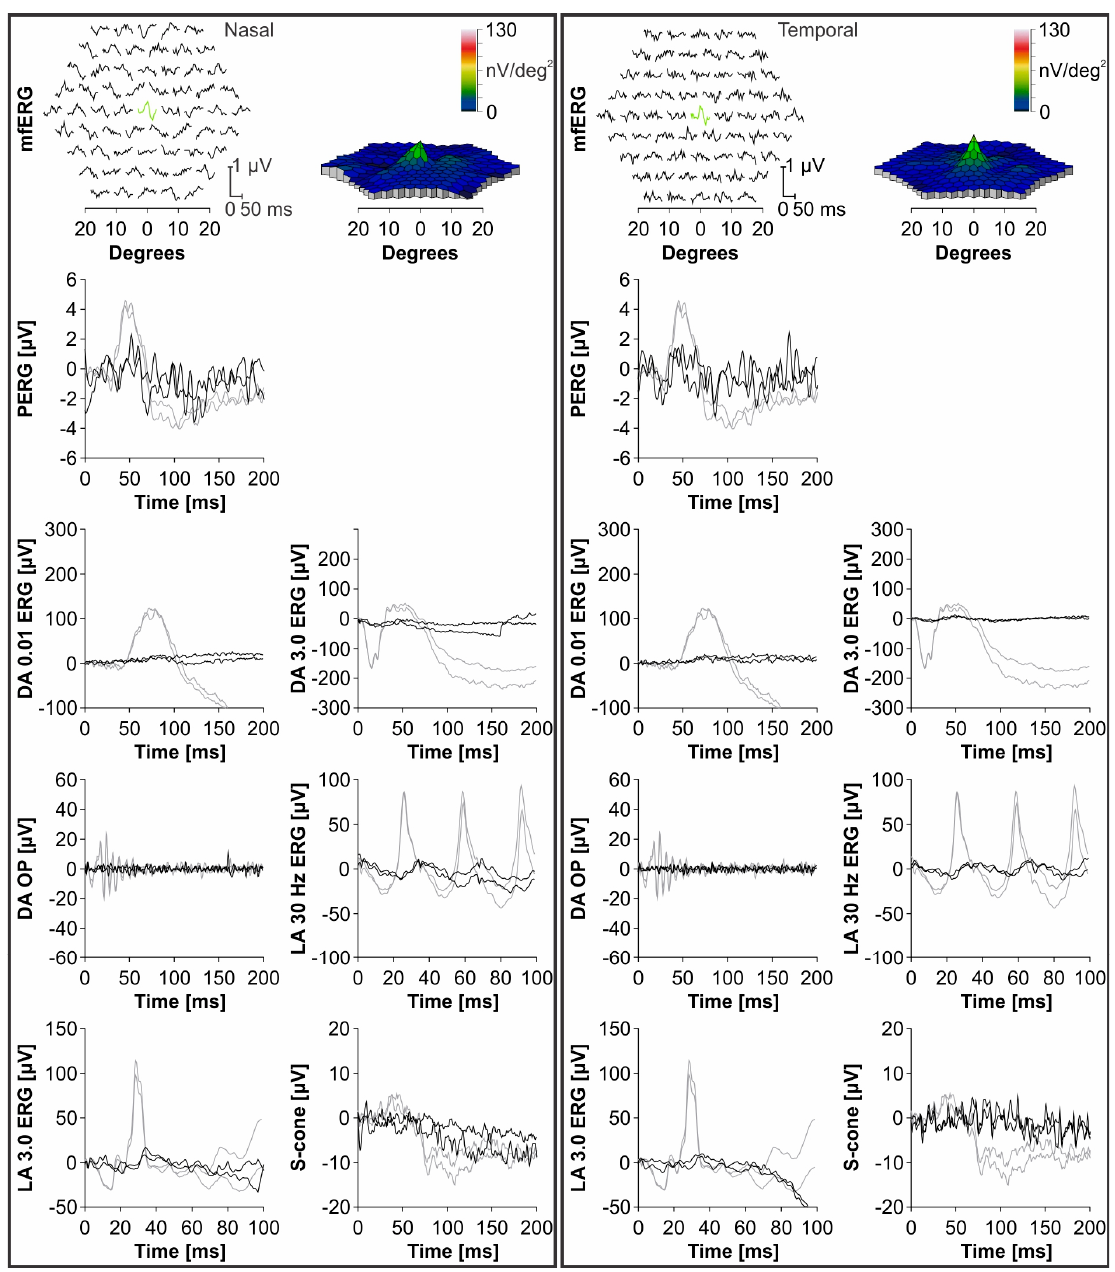
Figure 3. Right eye ( left column ) and left eye ( right column ) electroretinography (ERG) responses of the WDR19 patient at 24 years of age (black lines) and a healthy control (grey lines). Multifocal ERG (mfERG) responses of the WDR19 patient are shown at the top with a 3D representation of the values on the right side. All ERG responses of the WDR19 patient were below the normal range. Note the relatively severe loss of ERG responses representing rod system function (dark-adapted (DA) 0.01 ERG and DA 3.0 ERG) in comparison to light-adapted (LA) 30 Hz, which represents cone system function. Preserved foveal function in the first mfERG ring is marked with green.